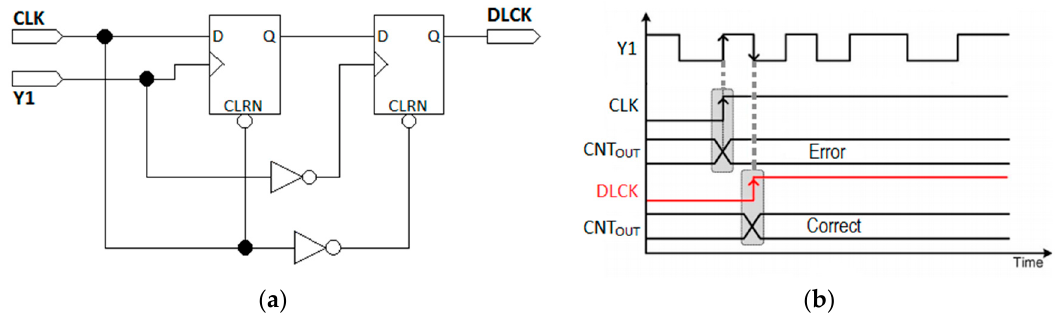
9 of 15 ( c ) Figure 8. Interstage synchronizer (IntS Sync): ( a ) block diagram; ( b ) timing diagram; ( c ) schematic of the edge-sensitive pulse generator (ESPG). 4.3. The 16-Bit Quantizer As described in Section 2, designer must set f S lower than f min to guarantee occurring a residue pulse each cycle. As f min > f S , a number of rising edges may appear in a sampling period and, thus, a multi-bit quantizer is needed. In the proposed FPGA-based TDC, built-in 16-bit counters count rising edges of the first and second stages outputs to quantize Y 1 and Y 2 in each sampling clock. Using such number of bits for quantization is a notable distinction point of the proposed TDC compared to previous works results in a better time-resolution. It is noteworthy that such an